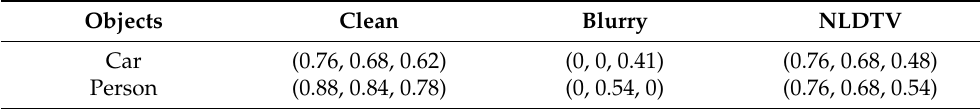
Figure 10. Object detection results of clean images, blurry images, and restored images by the Yolov7 [43]. The confidences of the detected objects, from left to right, are listed in Table 2. Table 2. The confidences of the detected objects (from left to right) in Figure